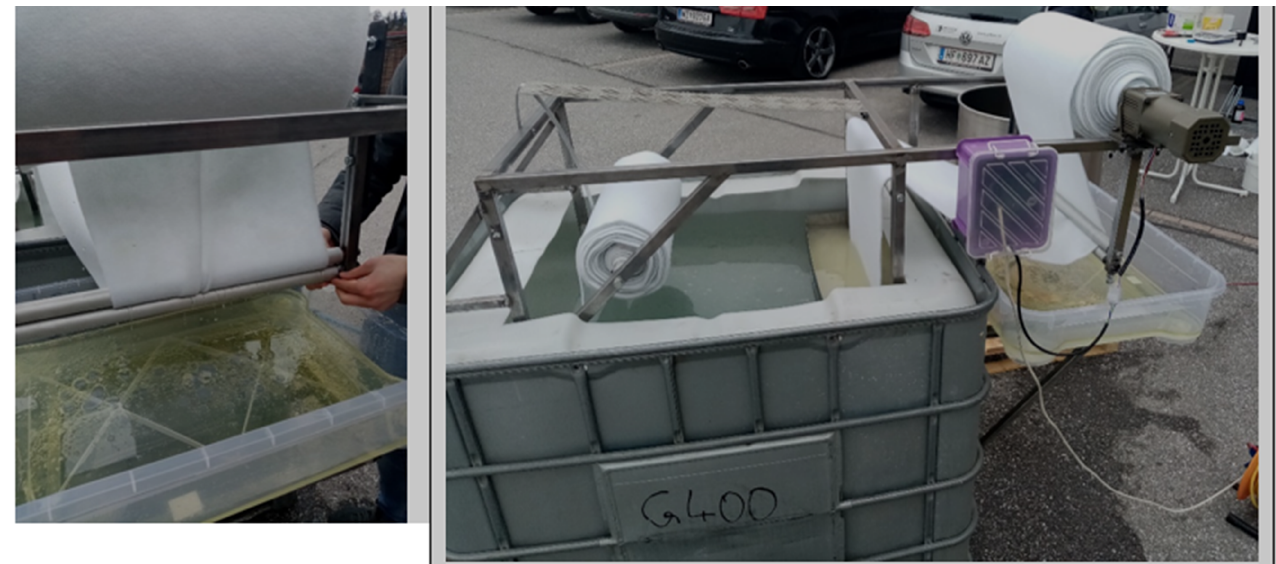
Figure 7. Prototype of the non-woven-based oil-and-water separator. Left : close-up of a non-woven laden with plant-oil being pressed out. Right : IBC installation with the emulsion to be separated in the middle and the pressed-out oil on the right.